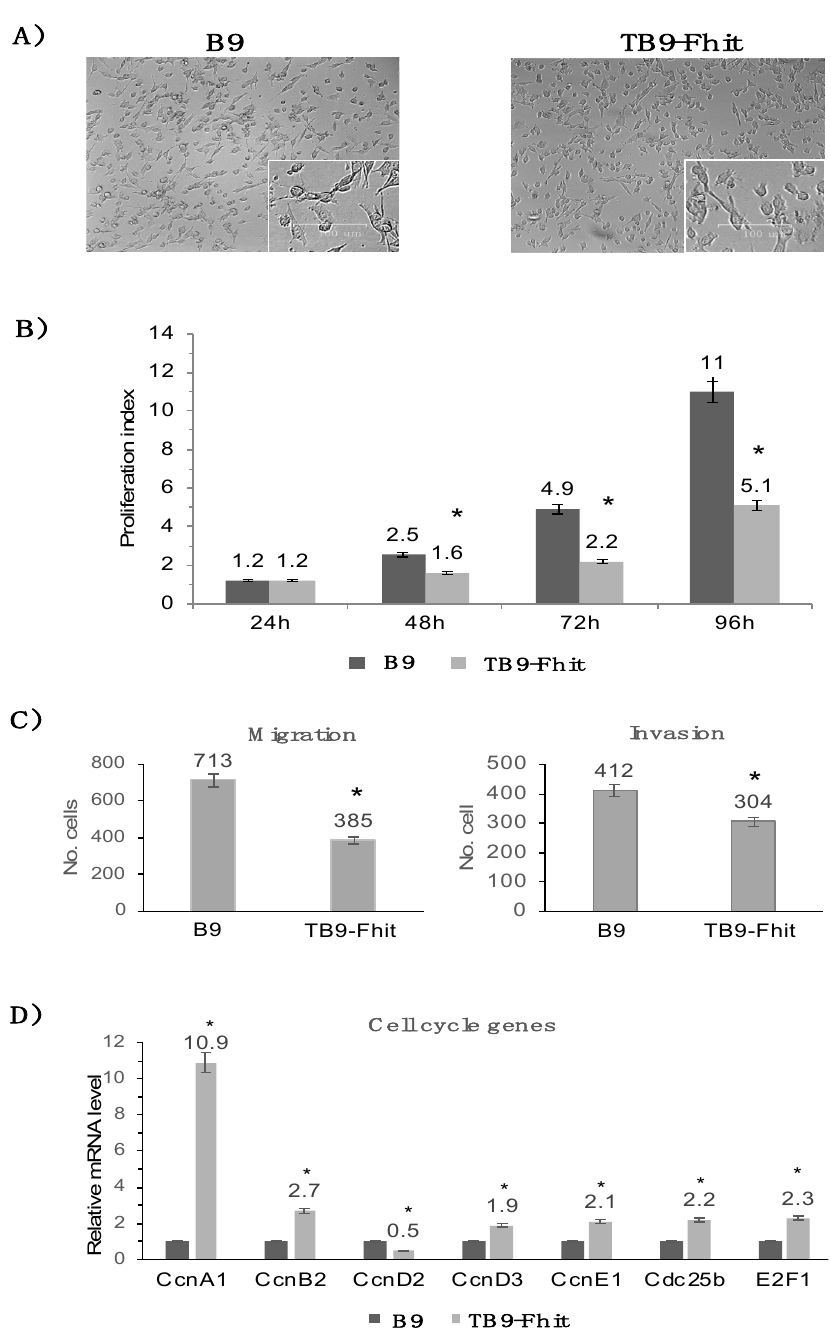
Figure 2. In vitro changes produced in B9 tumor cells by the Fhit gene transfection. ( A ) Microscopic image of B9 and TB9-Fhit tumor cell lines. Both tumor cell lines show very similar cellular morphology; ( B ) In vitro proliferation index of B9 and TB9-Fhit tumor cell lines. TB9-Fhit shows a lower proliferation index. The proliferation index was calculated: final cell number / initial cell number. Values are depicted as means ± SD of three independent experiments performed; ( C ) In vitro migration and invasion assays compare B9 and TB9-Fhit tumor cells. TB9-Fhit shows lower migratory and invasive potential. Values are depicted as means ± SD of three independent experiments; ( D ) Transcriptional expression of cell cycle genes in B9 and TB9-Fhit tumor cell lines. Data were normalized using β -actin and GAPDH as housekeeping genes. Only genes with changes in their expression are depicted. Data for B9 are set at 1. Values are depicted as means ± SD of three independent experiments performed in quadruplicate. * p < 0.05. A two-tailed Student’s t -test was used for statistical analysis. Scale bar, 100 µm.